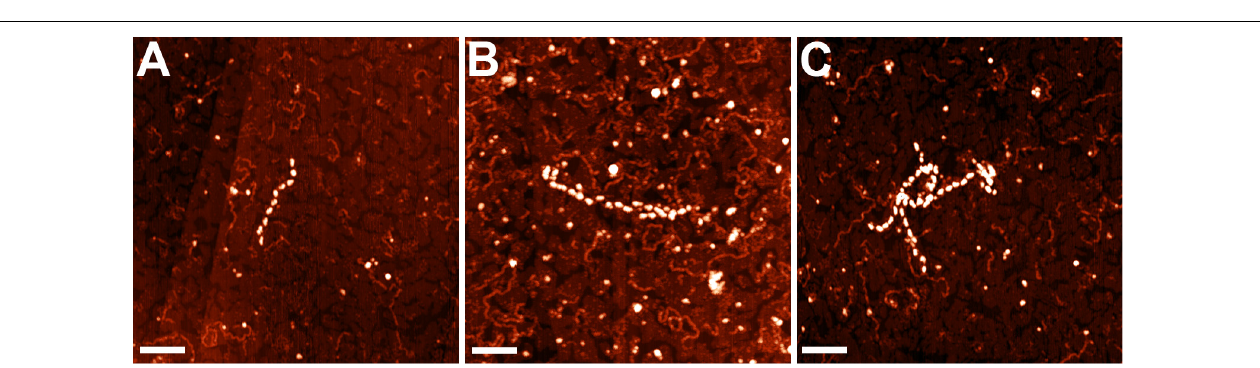
FIGURE 1 | AFM images of the M. gallisepticum nucleoid structural units at the exponential (A,B) and the stationary (C,D) growth phases. Bar = 100 nm.